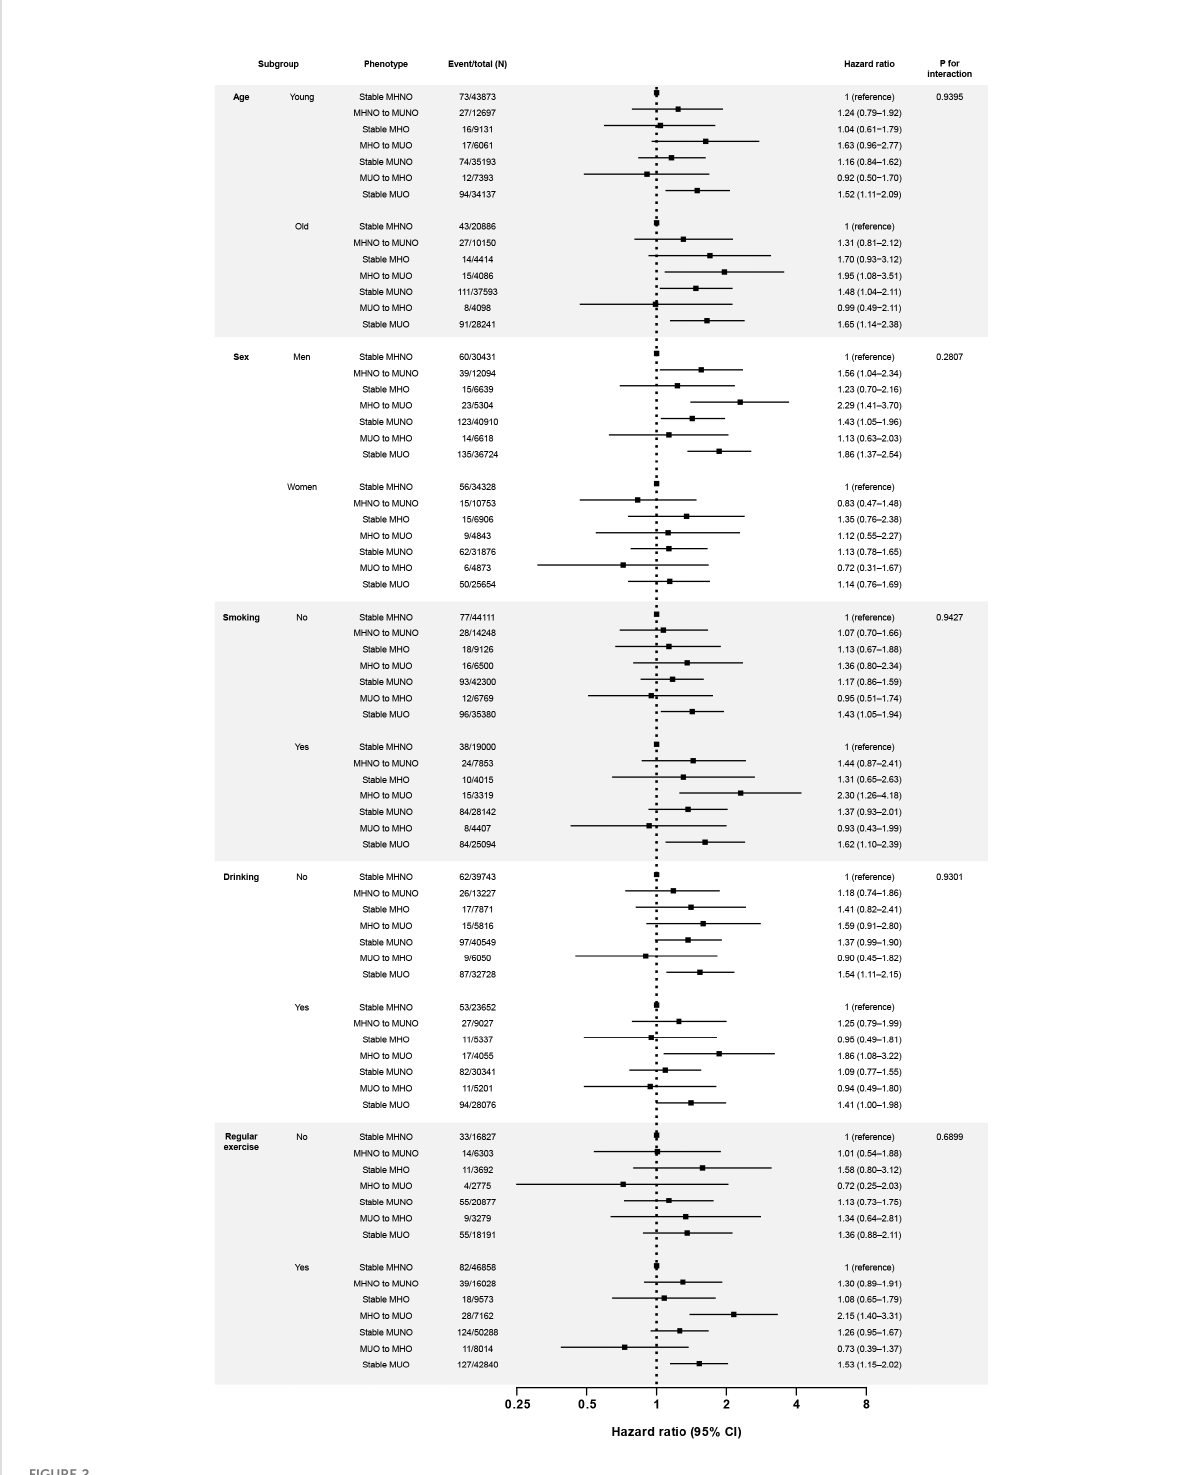
FIGURE 2 Subgroup analyses for the risk of kidney cancer according to the phenotypic transitions. The hazard ratios (95% con fi dence intervals) were adjusted for baseline age, sex, smoking habits, drinking habits, physical activity, and estimated glomerular fi ltration rate level. The covariates are excluded from the adjustment in the corresponding subgroup analyses. Abbreviations: MHNO, metabolically healthy non-obese; MHO, stable metabolically healthy obesity; MUO, metabolically unhealthy obesity; MUNO, metabolically unhealthy